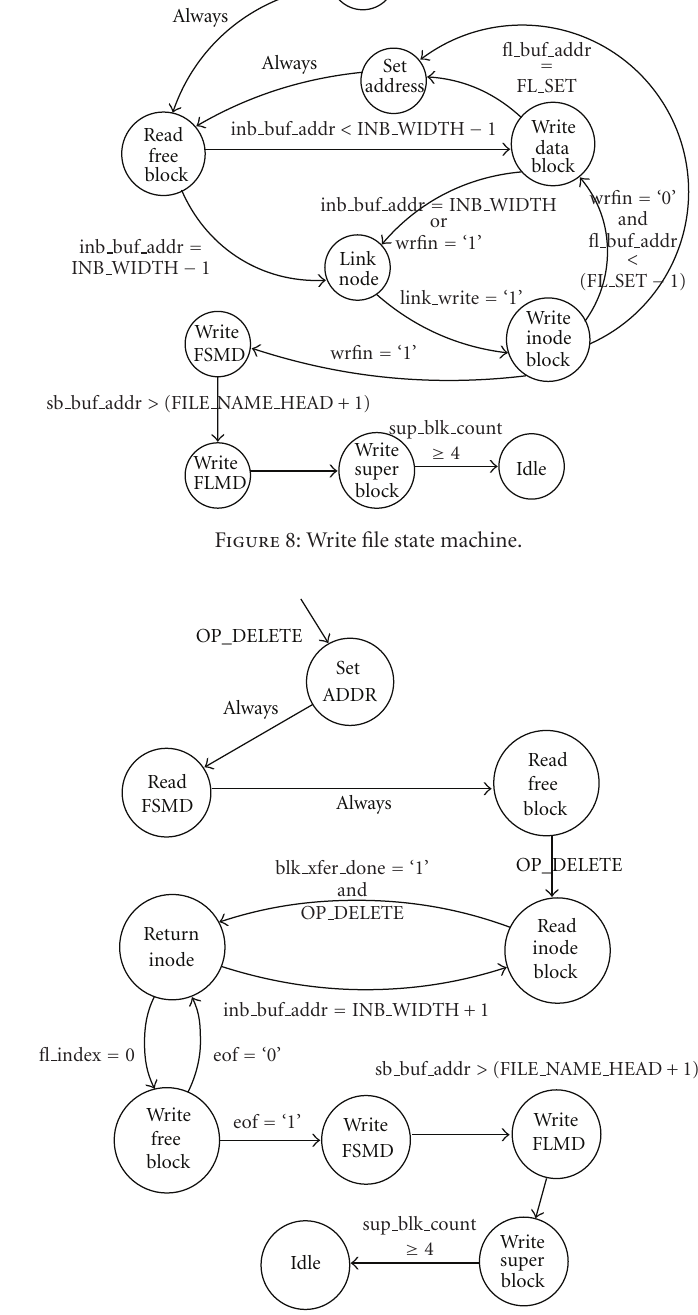
Figure 9: Delete file state